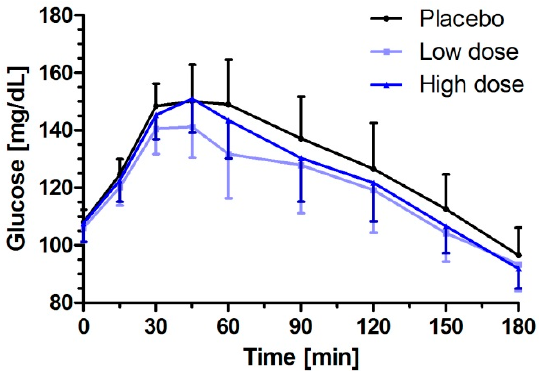
Figure 3. Glucose responses to a single intake of placebo or low- or high-dosed milk protein hydrolysate containing bioactive peptides consumed 15 min prior to a challenge meal. Data represent mean ±95% CI.